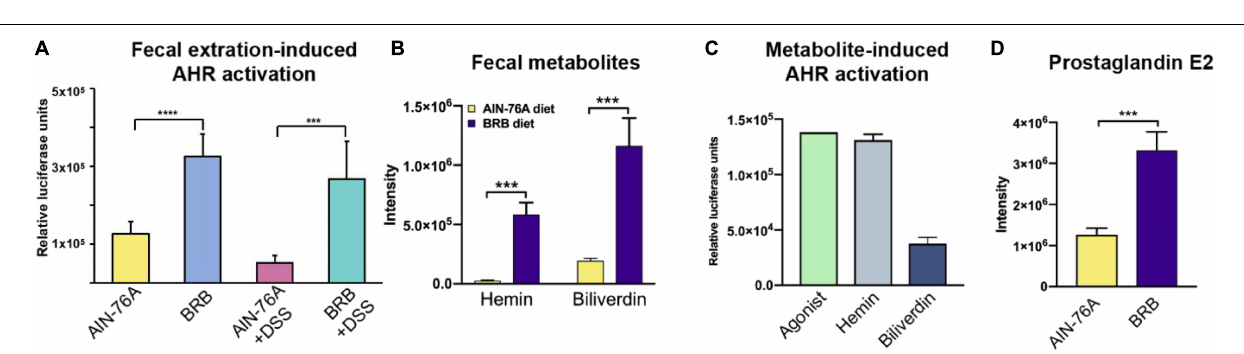
FIGURE 3 | Dextran sulfate sodium (DSS)-induced perturbation in gut microbial communities were partly rescued by BRB dietary intervention. (A) Alpha rarefactions using PD whole tree, observed OTUs, and chao1 metrics, the x -axis is sequencing depth; compared to control subjects, DSS induced significant reduction in alpha diversity, which was partly restored by BRB dietary intervention. (B) Principle coordinate analysis presents comparison of the mouse gut microbiota of different groups (AIN-76A, BRB, AIN-76A + DSS, BRB + DSS). Relative abundances of inflammation-associated gut bacterial genera including Anaerotruncus (C) , A genus in family Peptostreptococcaceae (D) , and Trabulsiella (E) . (AIN-76A, n = 10; AIN-76A + DSS, n = 9; BRB + DSS, n = 10; * p < 0.05), ** p < 0.01, *** p < 0.001.